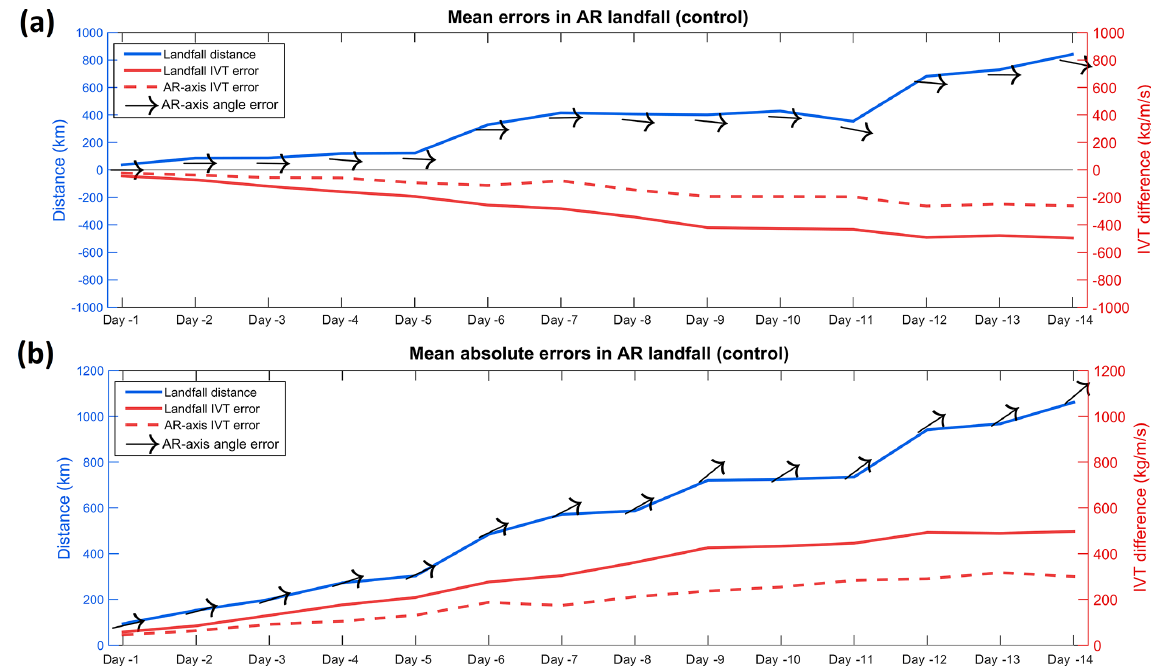
Figure 5. Verification of the accuracy of the control forecast of IVT for all events affecting western Iberia during the extended winters between 2012 and 2016 relative to mean errors (a) and absolute errors (b) is shown. The solid blue line represents the error in the location of the maximum IVT between the observation and each forecast (in kilometers). The solid red line shows the error in the IVT (kgm − 1 s − 1 ) for each forecast at the real landfall location (where the maximum IVT was observed), while the dashed red curve represents the error in the maximum IVT between the observed values and each lead time forecast, independent of the location in each forecast. The black arrows represent the errors in the angle (in degrees) of the AR